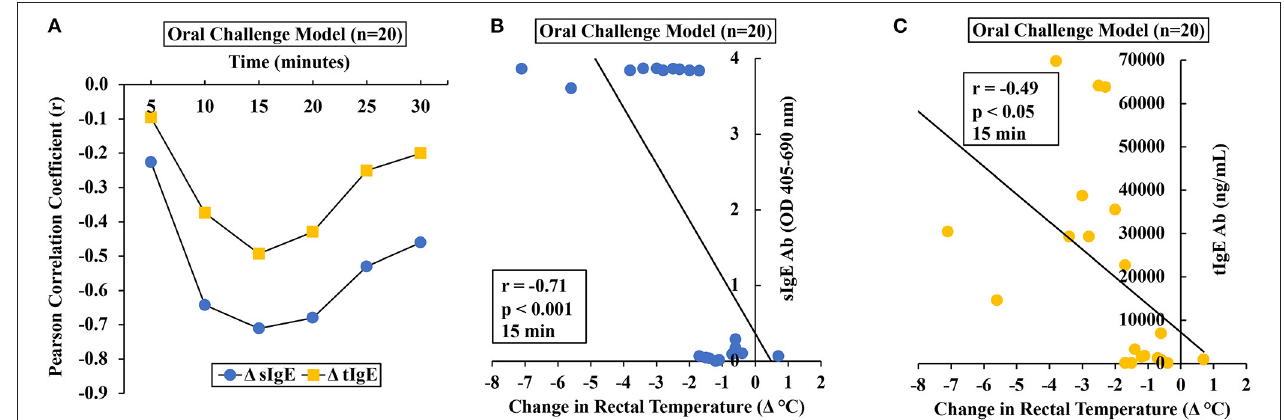
FIGURE 3 | Anaphylactic responses in allergic mice upon oral challenge with durum wheat (genomes AABB) SSPE correlated with specific and total IgE levels. Mice were exposed to SSPE or to saline and challenged as described in Materials and Methods. (A – C) Pearson correlation coefficient ( r ) between antibody responses (sIgE or tIgE levels) and change in rectal temperature ( 1 ◦ C) in mice sensitized and orally challenged with SSPE (20mg). (A) Pearson correlation coefficient ( r ) at indicated time points. (B) Pearson correlation analysis between sIgE and 1 ◦ C at 15min post challenge. (C) Pearson correlation analysis between tIgE and 1 ◦ C at 15min